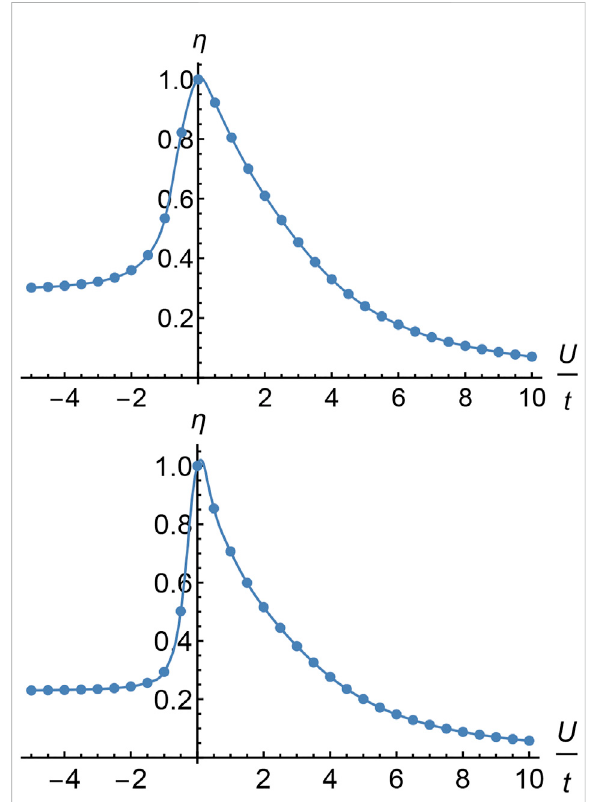
According to the Bethe assumption method, the Eq. 17 related to the degree of entanglement can be obtained, which shows the relationship between the degree of entanglement η (vertical axis) and U / t (horizontal axis). The aforementioned two fi gures are, respectively, the relationship curves of entanglement degree η and U / t whenthetotalnumberofparticles is 10 and 20. It can be seen that the degree of entanglement tends to 1 as U / t → 0, so the two particles in the model can be entangled by controlling the values of parameters U / t